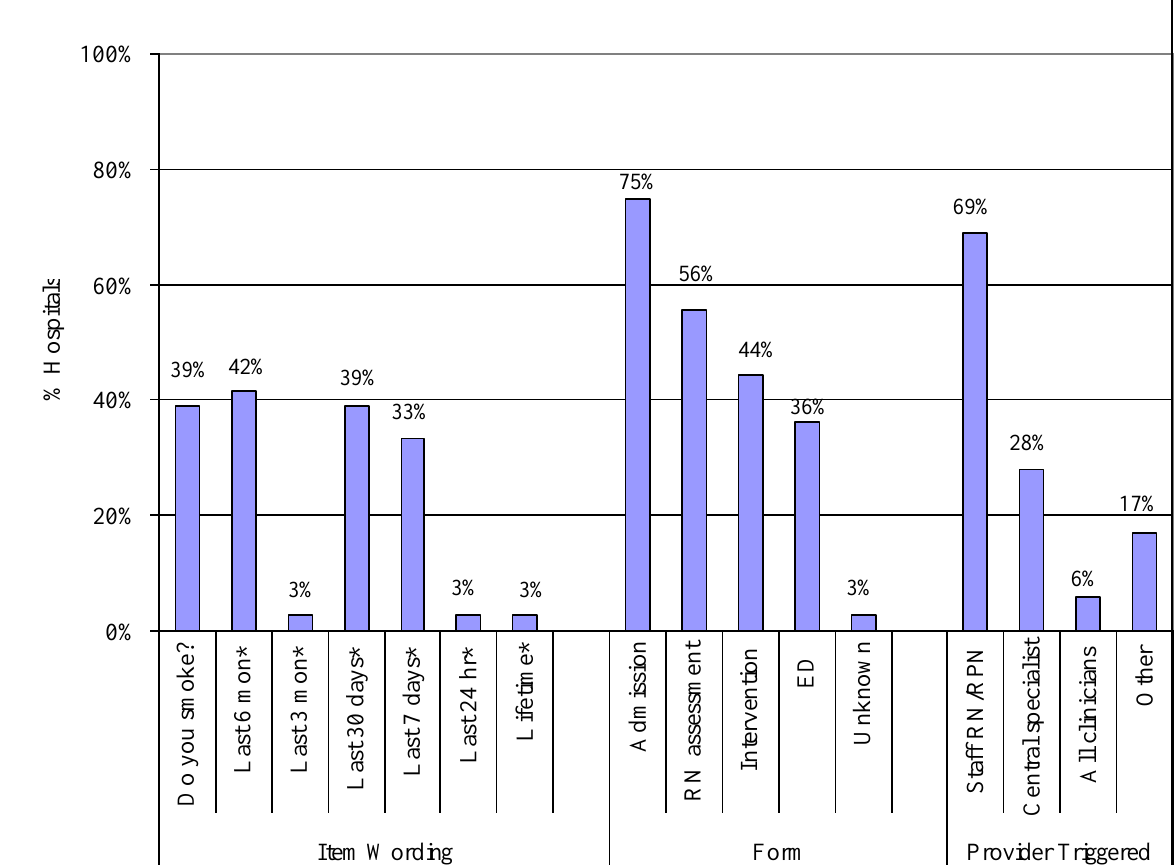
Figure 1. Tobacco use item wording, location, and providers who are triggered to provide a cessation